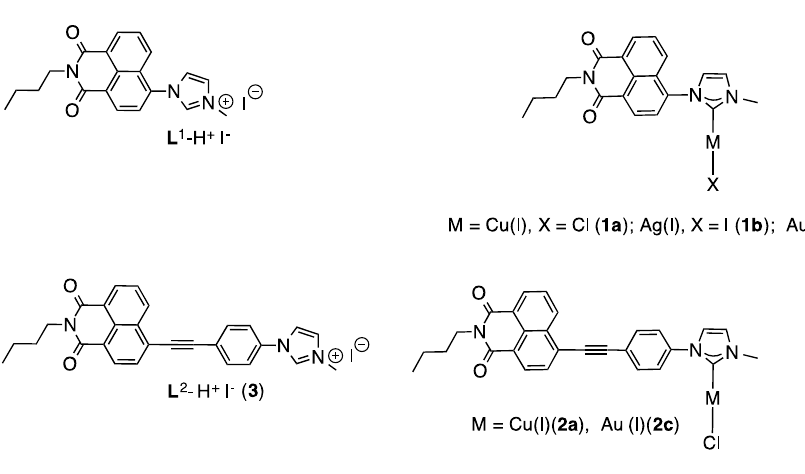
Figure 1. Ligand precursors L 1 –H + I − and L 2 –H + I − and the related NHC carbene complexes with naphthalimide chromophore described in this work.